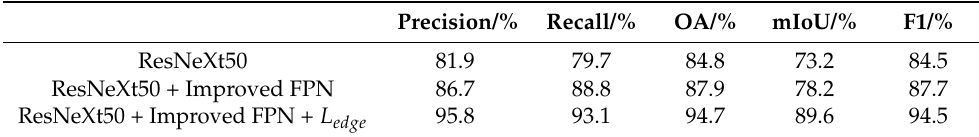
Table 4. Comparison of Mask R-CNN and two improved